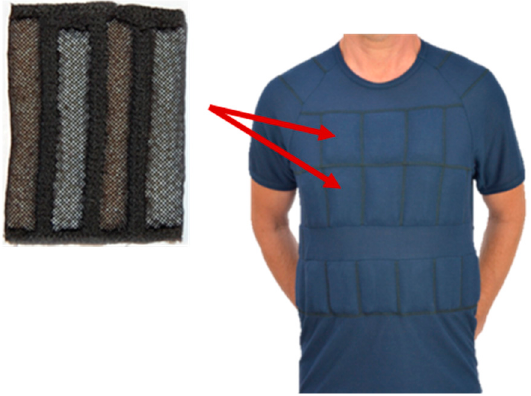
Figure 1. A view of protective T-shirt with PCM